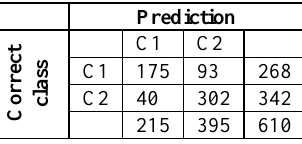
Table 2. Confusion matrix. C1 – intact buildings, C2 –destroyed buildings.